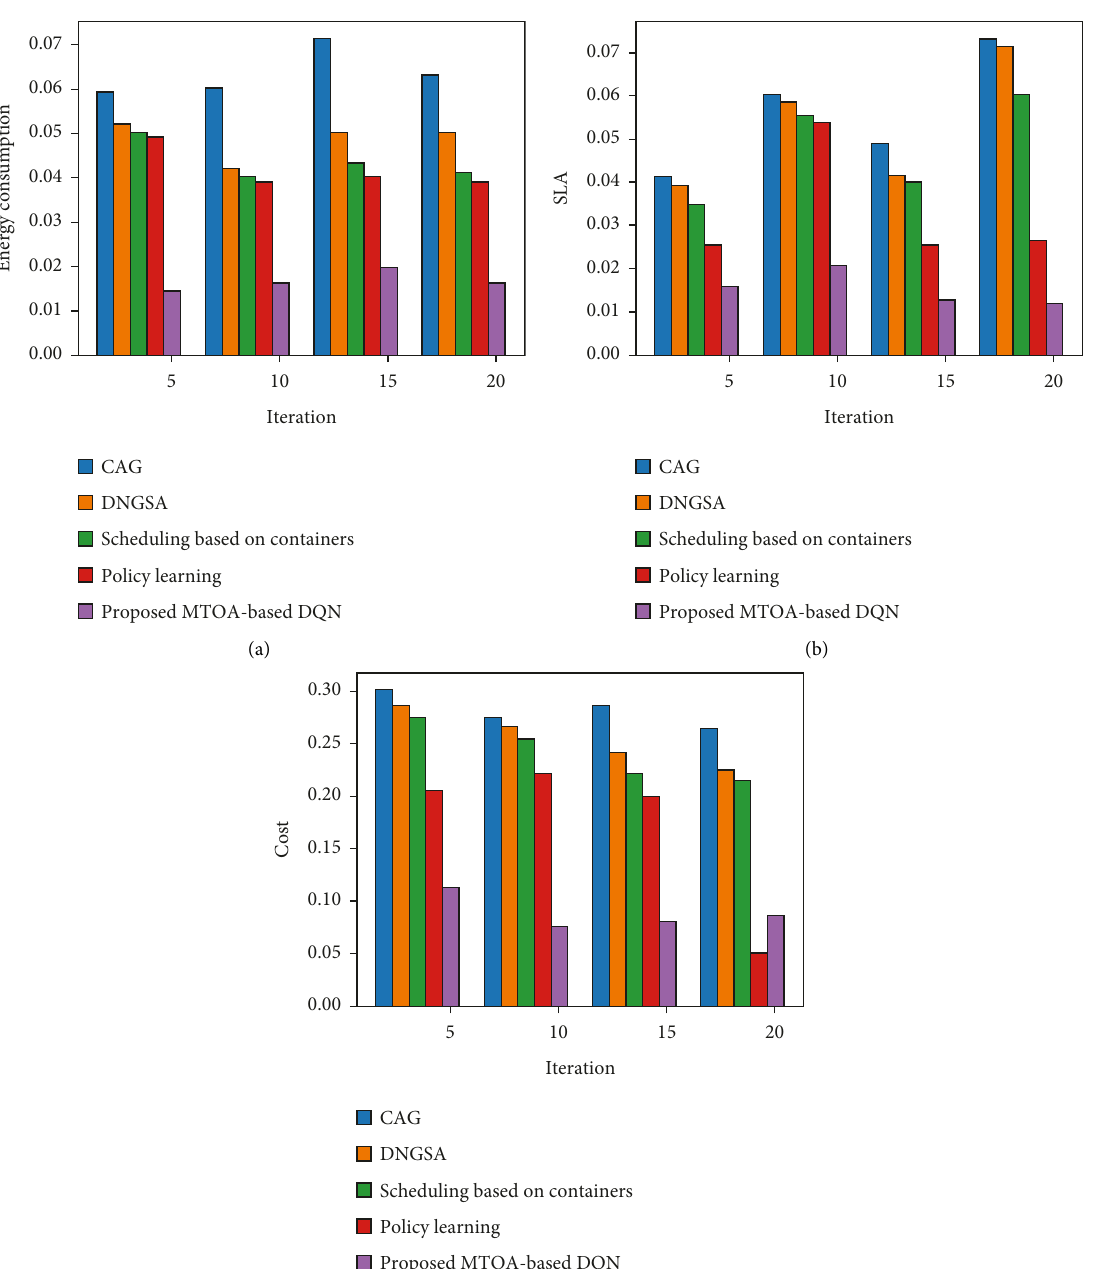
Figure 8: MTOA-based DQN with 500VM using Rnd data. (a) Energy consumption, (b) SLA, and (c)